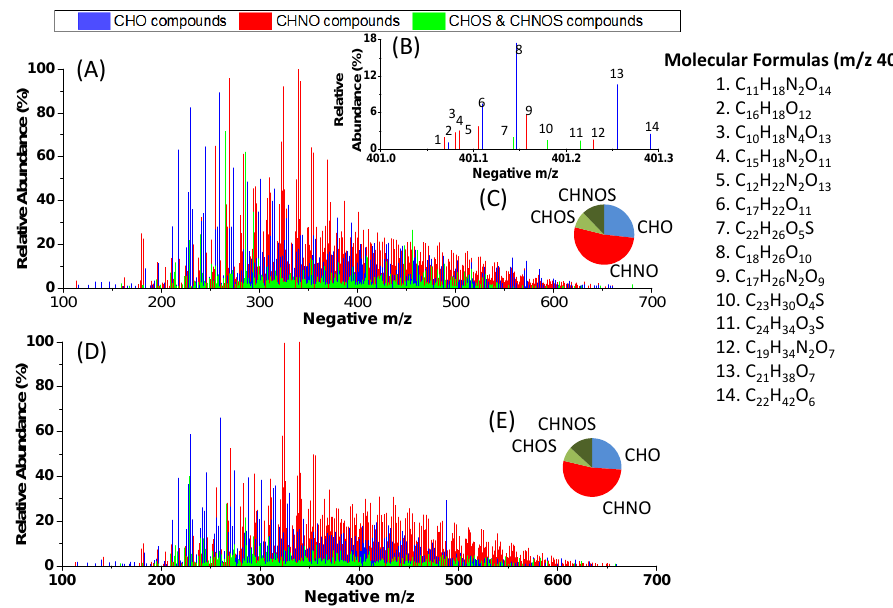
Fig. 1. Reconstructed mass spectra of the identified monoisotopic molecular formulas for CW1 (a ) and (b) and CW2 (d) : an excerpt of the CW1 mass spectrum from m/z 401.00 to 401.30 is shown in (b) with a list of the numbered analytes and their identified molecular formulas. Pie charts indicate the number fraction of the identified monoisotopic molecular formula groups for CW1 (c) and CW2 (e) .